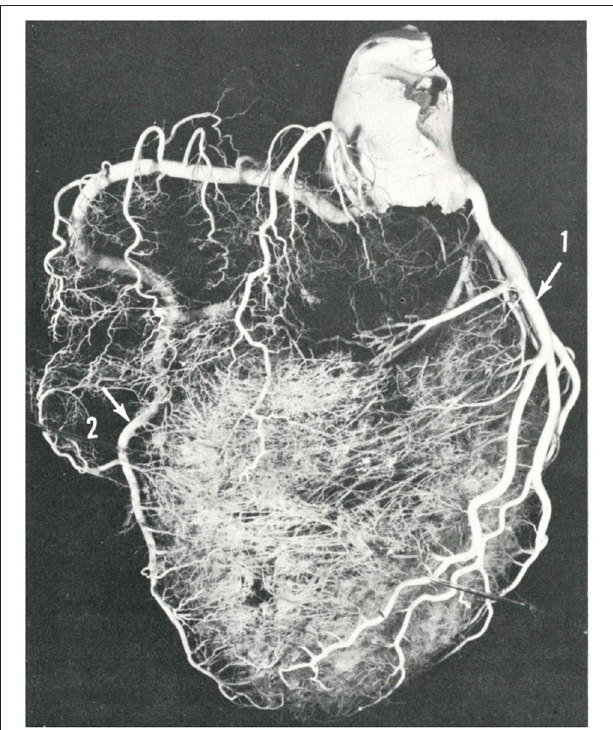
FIGURE 6 | The blood flow of the ventricular septum is supported by perforating branches, originating from the anterior and posterior descending coronary arteries. From Baroldi and Scomazzoni (3).